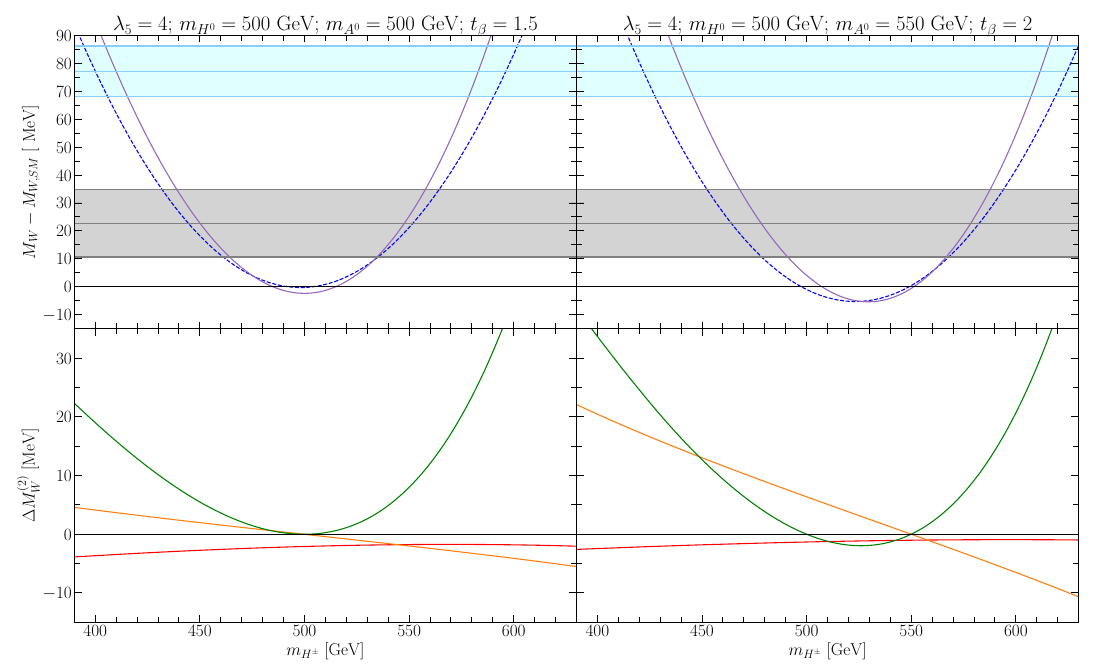
Fig. 1 Shift in M W from non-standard Higgs boson mass splittings. TheupperpanelsshowthedifferencetotheSMresult,atone-looporder (blue dashed line) and with all the available non-standard corrections (purple line). The current world average with 1 σ range is displayed by